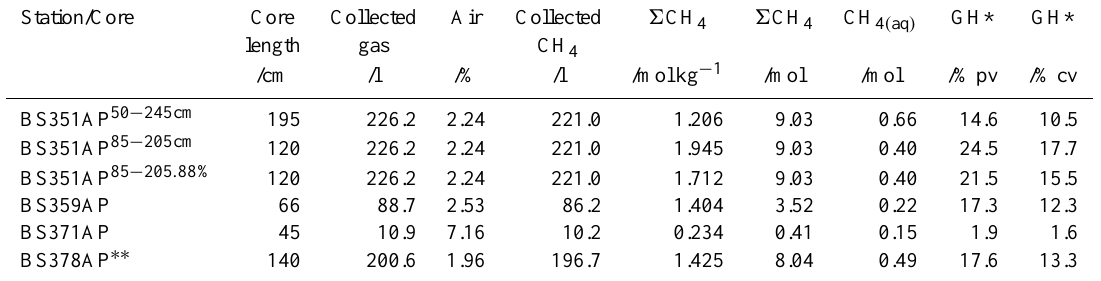
Table 2. Data from gas collection including volumes of collected gas, CH 4 , and gas hydrate as well as dissolved and total CH 4 concentrations in DAPC sediment cores between the depth of sulfate depletion and the core bottom (except BS351AP 85 − 205cm and BS351AP 85 − 205 . 88% ) . Station/Core Core Collected